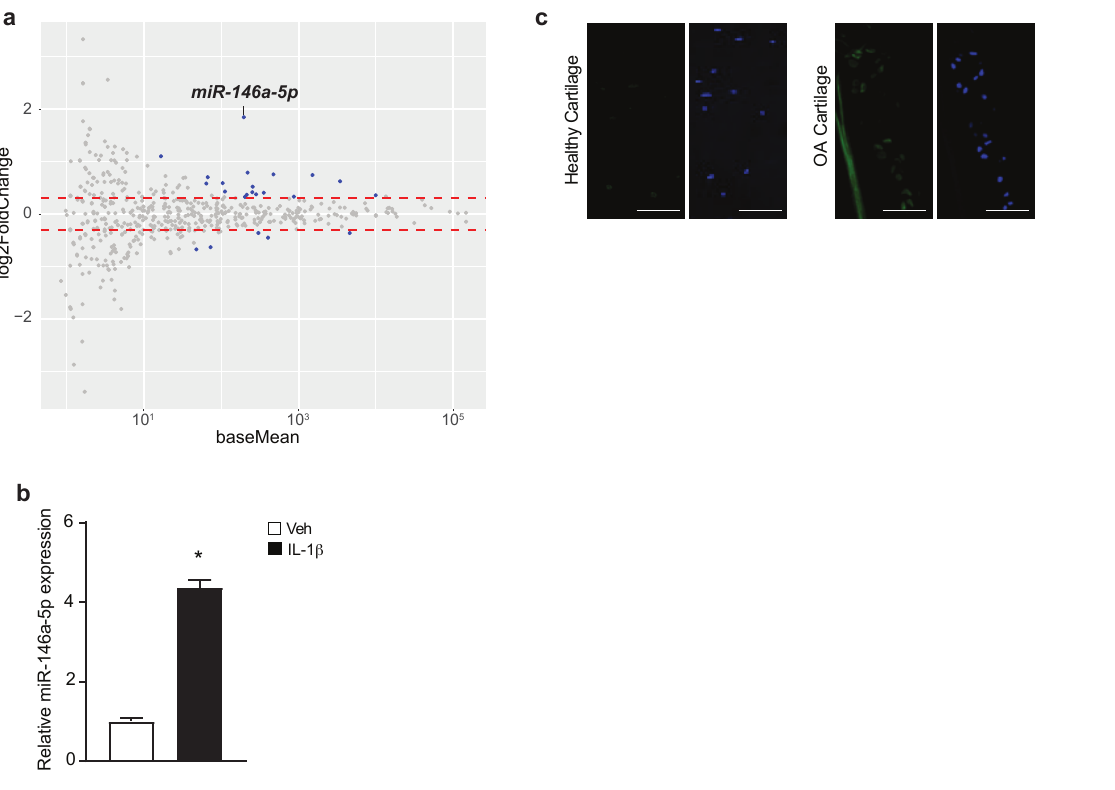
Figure 2. miR-146a-5p is induced by IL-1 β in murine articular chondrocytes and is elevated in human OA cartilage. ( a ) MA plot of miRNA expression profiling from microRNA-Seq (miRNA-Seq) assays with IL-1 β or vehicle-treated primary murine articular chondrocytes. Differentially expressed genes (DEGs) (Log 2 FoldChange > 0.3, Padj < 0.05) between IL-1 β and vehicle groups were highlighted in blue (n = 4); ( b ) Real-time qPCR for miR-146a-5p in IL-1 β - or vehicle-treated primary murine articular chondrocytes (n = 3); ( c ) Fluorescent in situ hybridization (FISH) for miR-146a-5p on articular cartilage sections from healthy donors or OA patients (n = 3) (scale bar, 100 µ m). Data presented as mean ± SD. * p < 0.05 by Student’s t